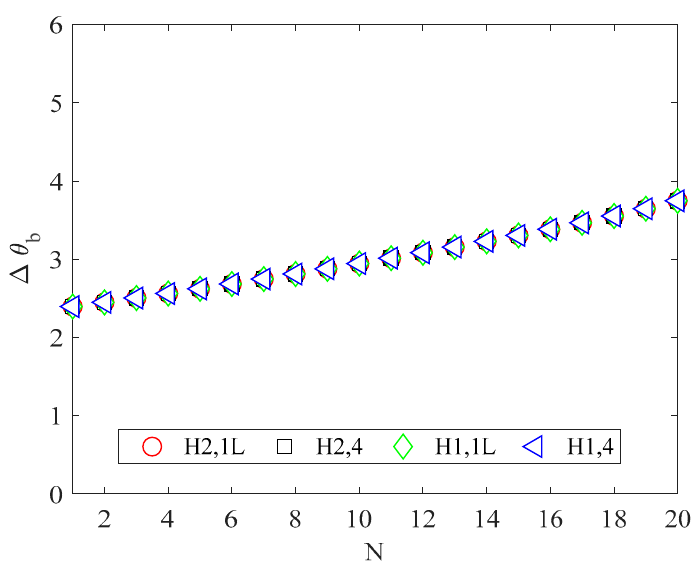
Figure 5. Increase in the air bulk temperature (°C).